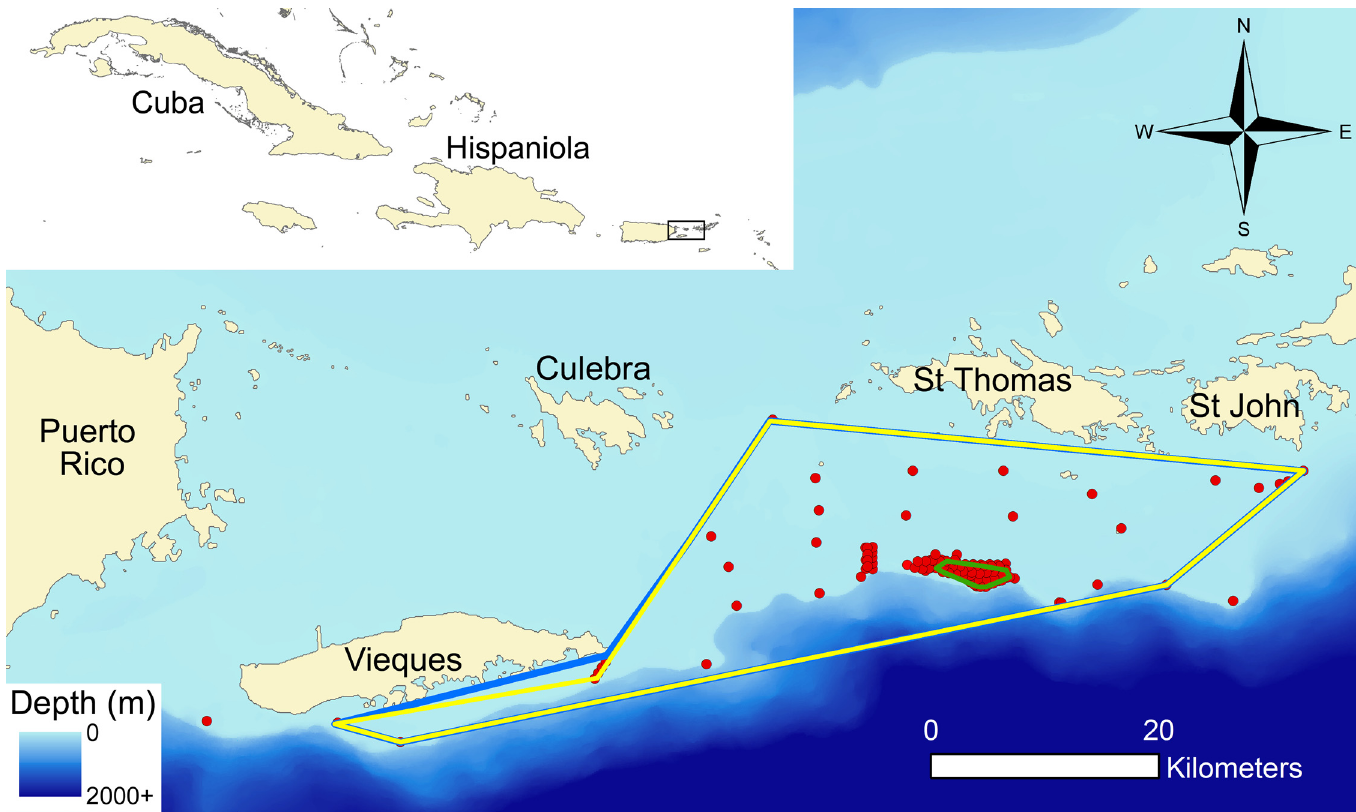
Fig 1. Acoustic array located along the southern edge of the Puerto Rico-Virgin Islands platform. Red circles represent locations of acoustic receivers. Minimum convex polygons (MCP) for three species of sharks quantified by acoustic tracking are indicated for all tiger sharks (blue line, 887 km 2 ), lemon sharks (yellow line, 863 km 2 ) and Caribbean reef sharks (green line, 8 km 2